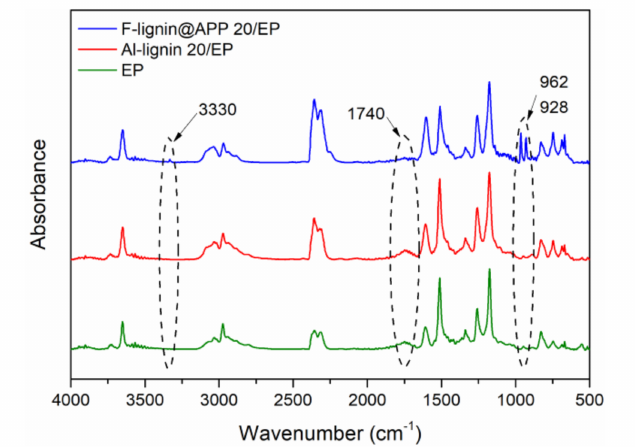
Figure 6. FTIR spectra of the volatile products of EP, Al-lignin 20 / EP and F-lignin@APP20 /